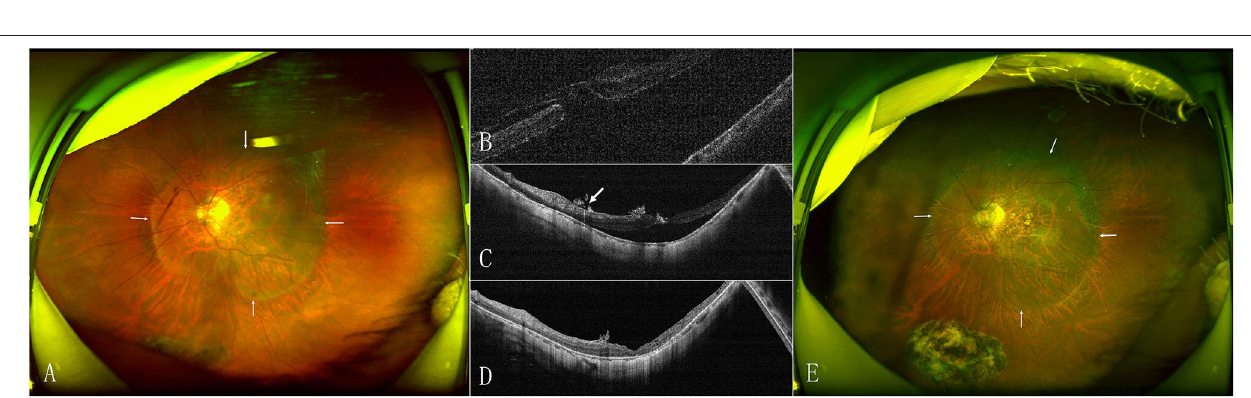
FIGURE 1 | Preoperative and postoperative scanning laser opthalmoscope (SLO) and optical coherence tomography (OCT) images of the eye of a 56-year-old woman with macular hole retinal detachment (MHRD) in the adjustable positioning group. (A) SLO shows the retinal detachment (RD) beyond vascular arcade (arrow). (B) Preoperative OCT confirms the macular hole (MH). (C) OCT shows MH closure and retinal reattachment with inserted internal limiting membrane (ILM) tissue (arrow) plugged into the hole at 2 weeks after surgery. (D) OCT shows the foveal microstructure recovery in eyes with MH closure at 6 months. (E) SLO shows silicone oil emulsification (white arrow) and chorioretinal atrophic lesion (black arrow) at 6 months.